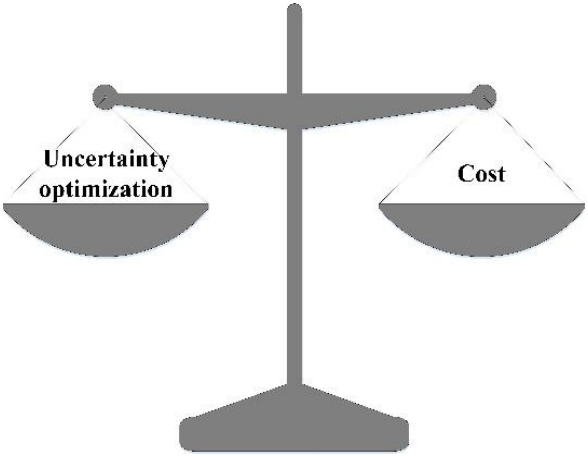
Figure 4. Relationship between uncertainty optimization and overall cost.